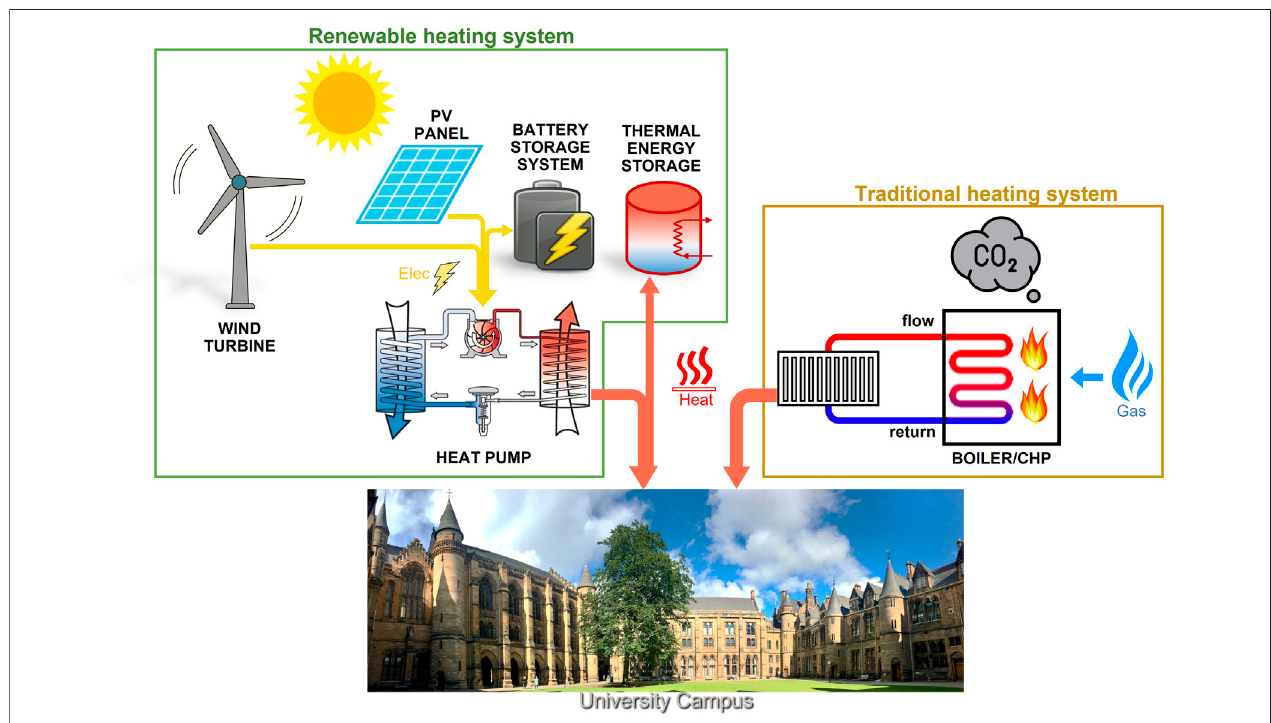
FIGURE 1 | Heating system of university